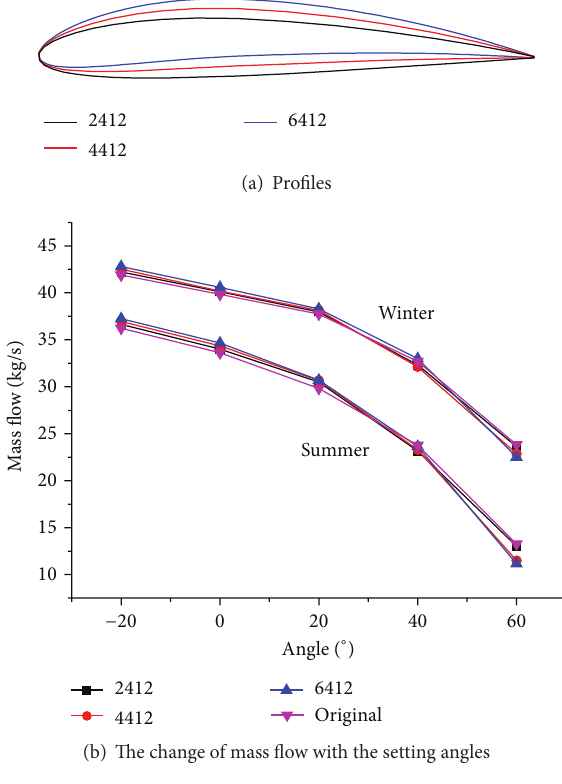
Figure 13: Different camber guide vanes.